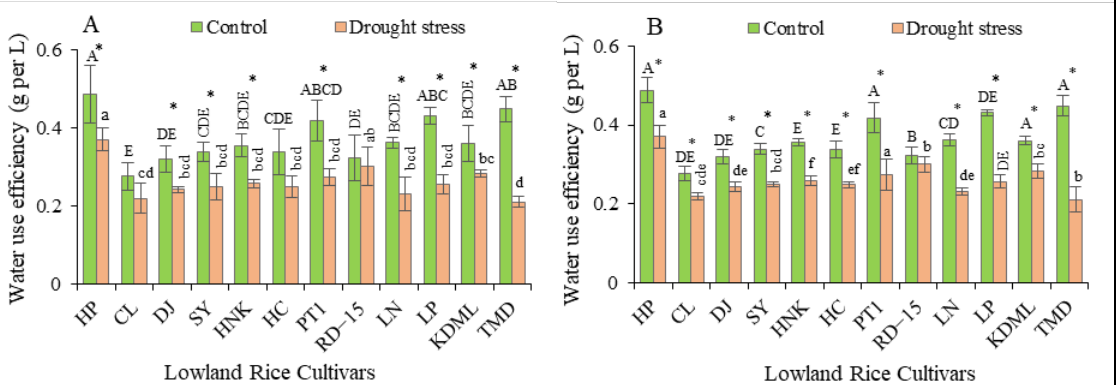
Figure 3. Water use efficiency of twelve lowland rice cultivars under control and drought stress treatments during first season ( A ) and second season ( B ). Means from three replications are presented with ± standard errors. Significance ( p < 0.05) among cultivars in control treatment is presented using capital letters, whereas significance ( p < 0.05) among cultivars in drought stress treatment is presented using lower-case letters. Significance among treatments for each cultivar is presented by stars (*). HP: Hom Pathum, CL: Chor Lung, DJ: Dum Ja, SY: Sang Yod, HNK: Hom Nang kaew, HC: Hom Chan, PT1: Pathum Thani−1, LN: Lep Nok, LP: Look Pla, KDML: Khao Dawk Mali−105, TMD: Tia Malay Dang .